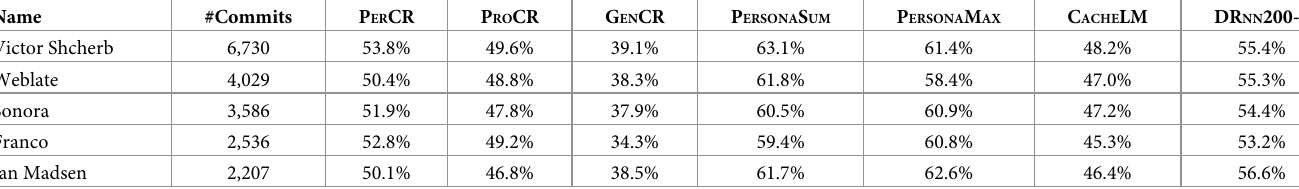
Table 4. Recommendation accuracy of top-contributed programmers in osmand .